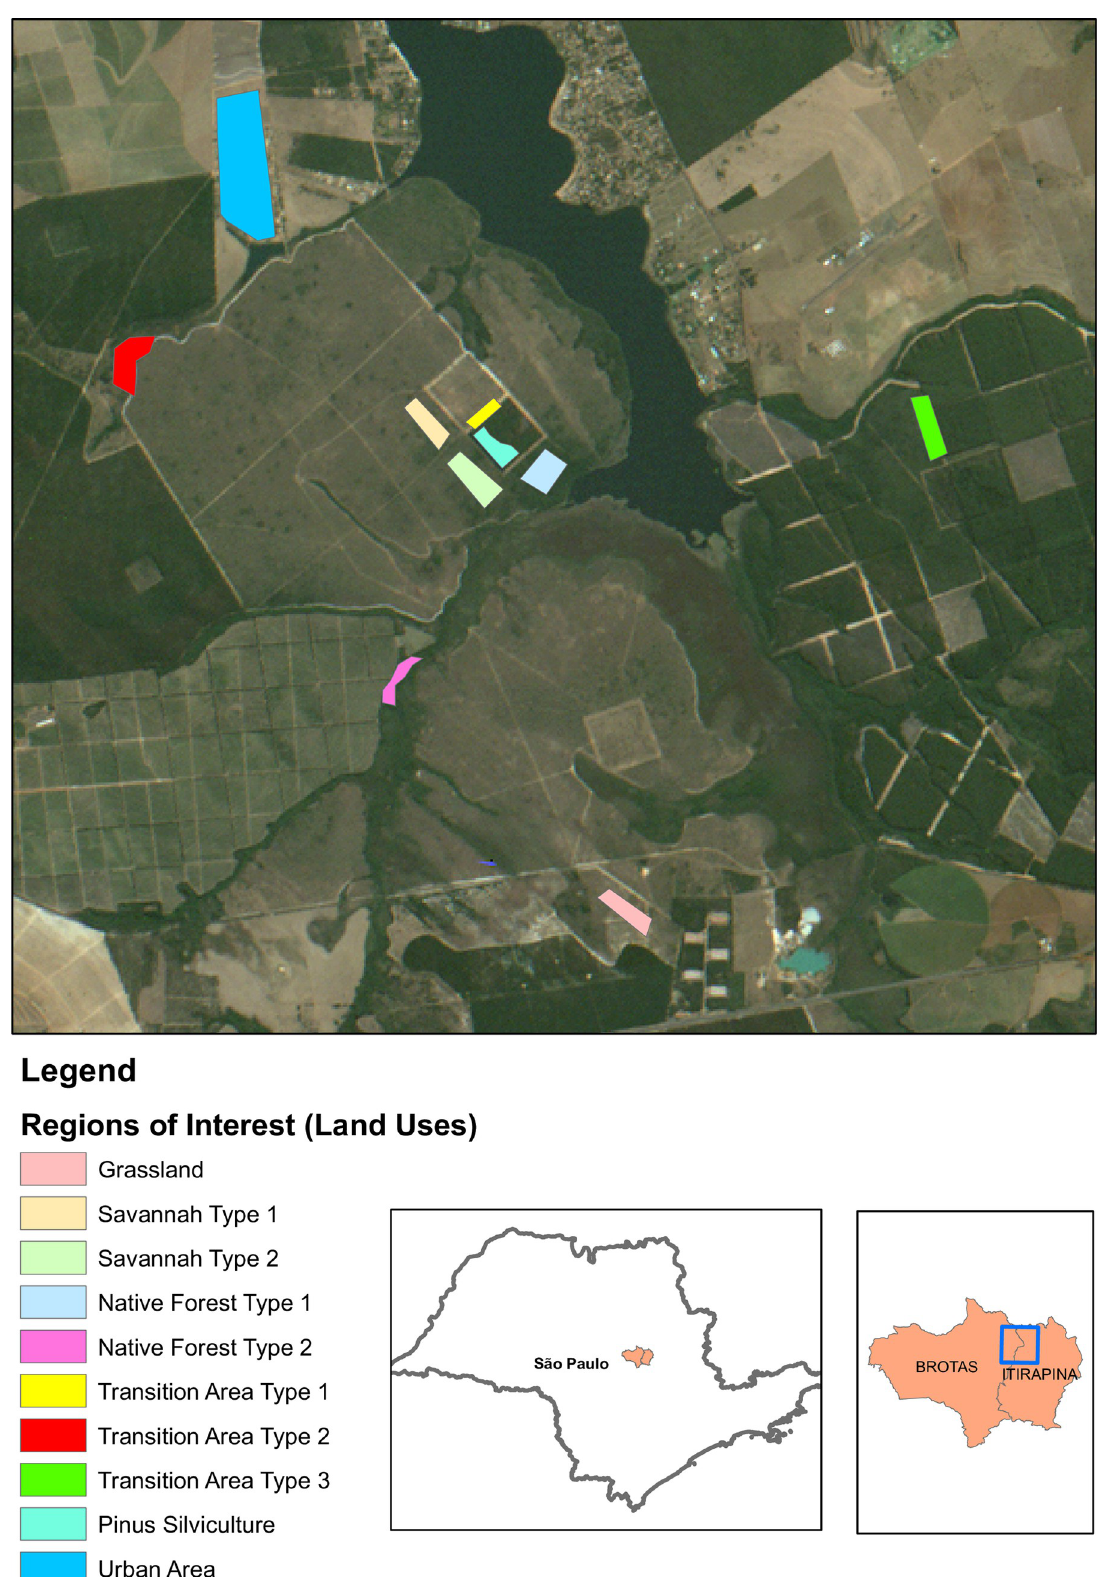
Fig 7. Regions of interest (ROIs) selected from the Itirapina Ecological and Experimental Parks and their surroundings (State of Sao Paulo, Brazil). (CBERS-4 image courtesy of the Brazilian National Institute for Space Research).